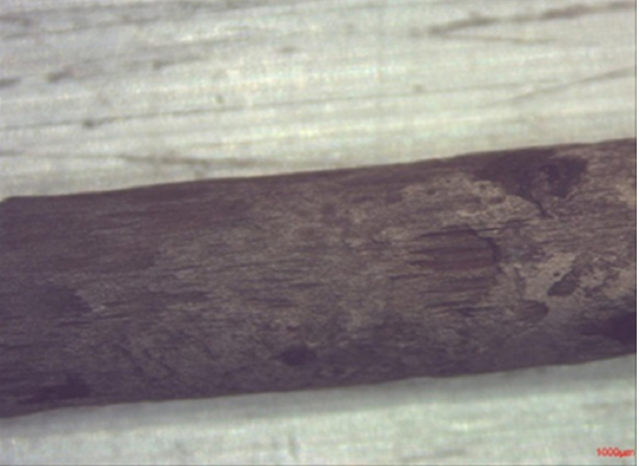
Figure 16. Close up of specimen C, 50 mm cover.